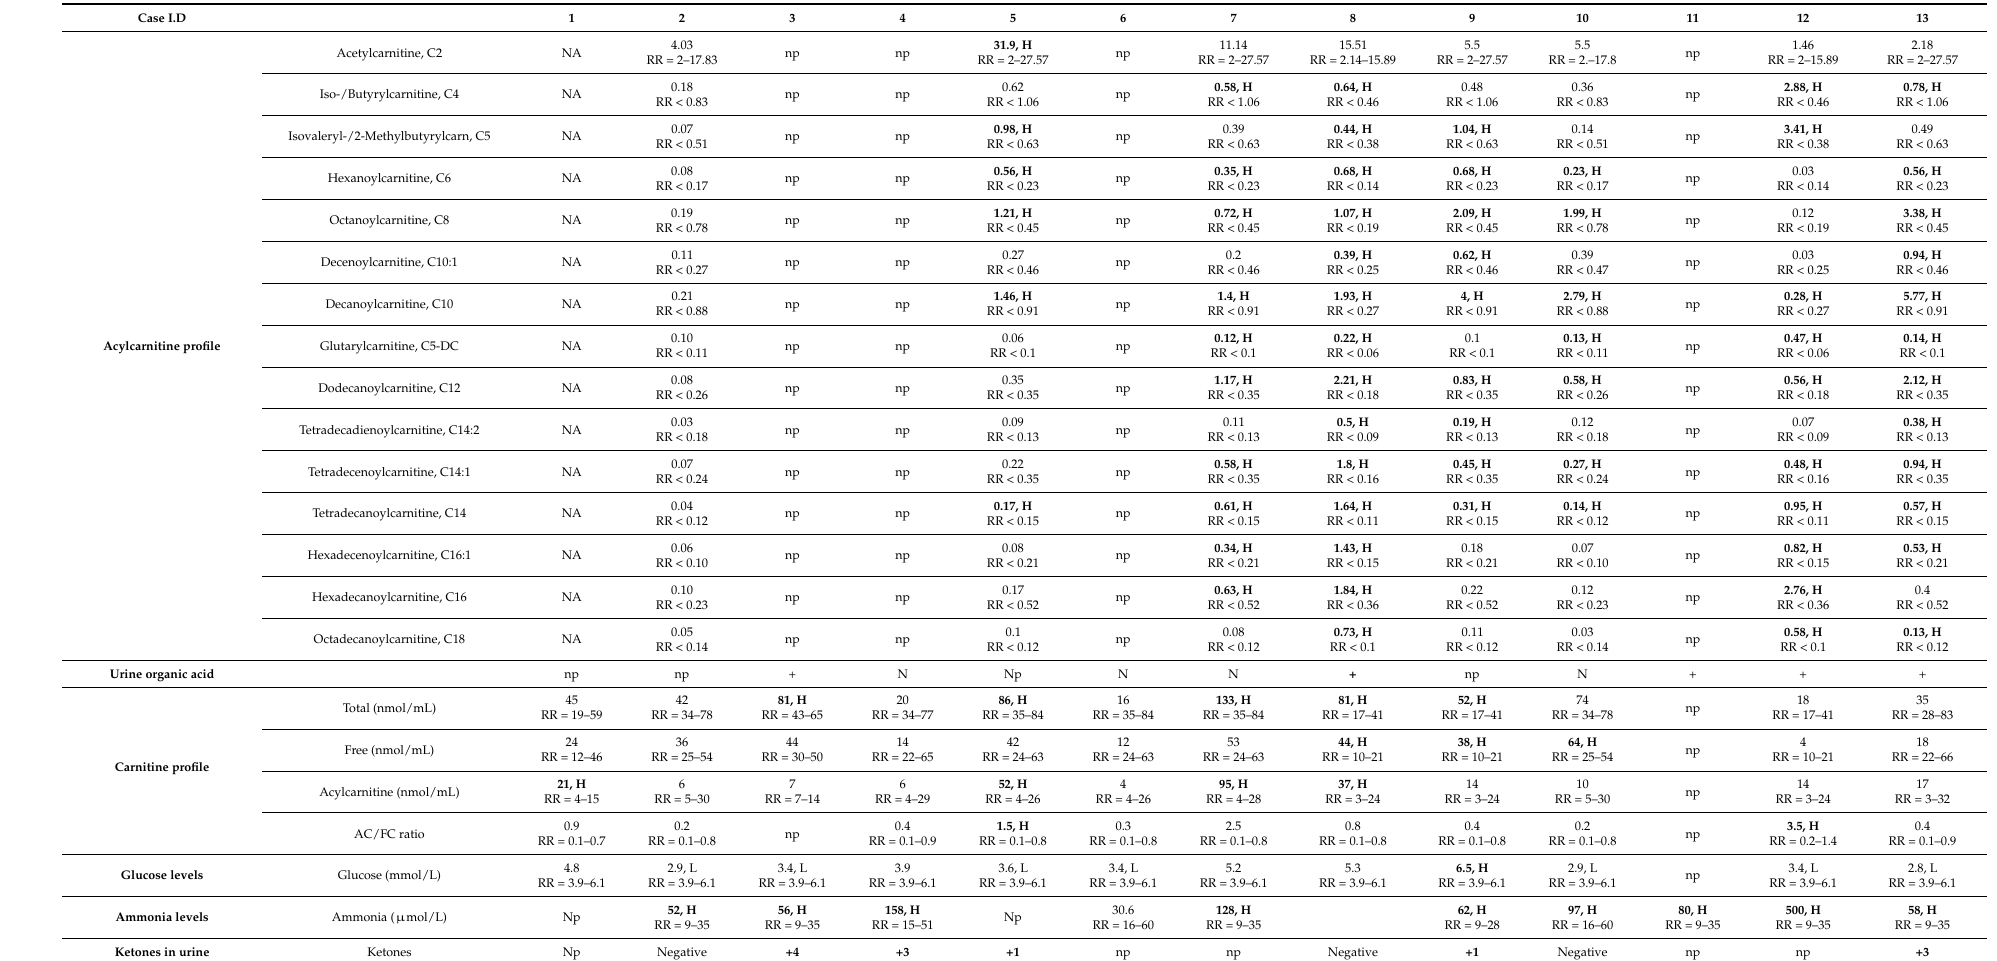
Table 2. Biochemical findings of studied